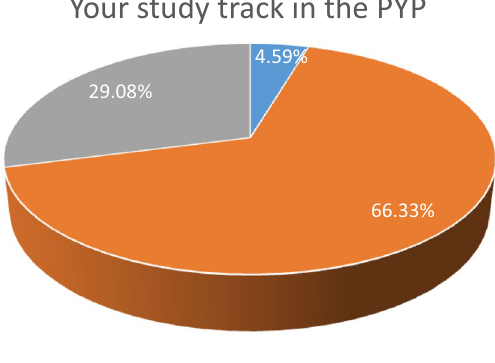
Fig. 2 Study track of the